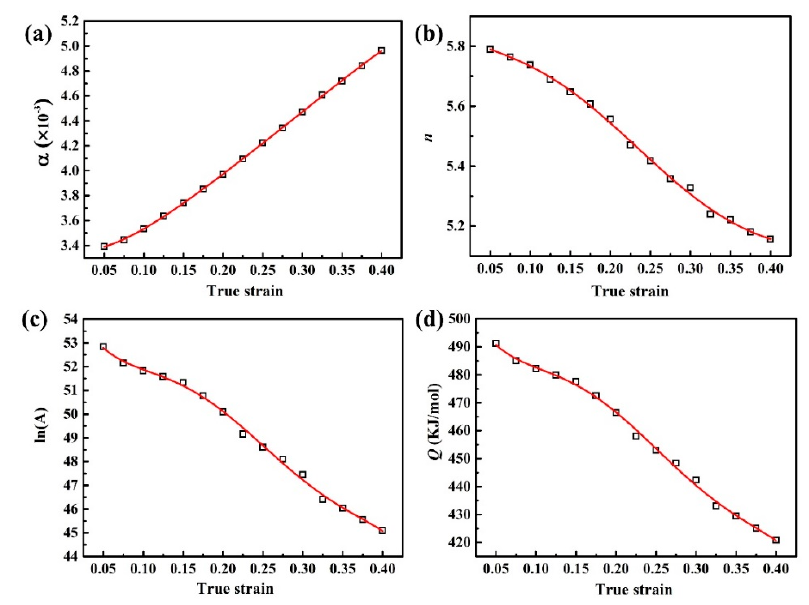
Figure 8. The material constants that vary with the strain: ( a ) α , ( b ) n , ( c ) ln A , and ( d ) Q . Table 4. The resulting fitting coefficients of α , n , ln A , and Q of as ‐ printed Ti–6Al–4V alloy.